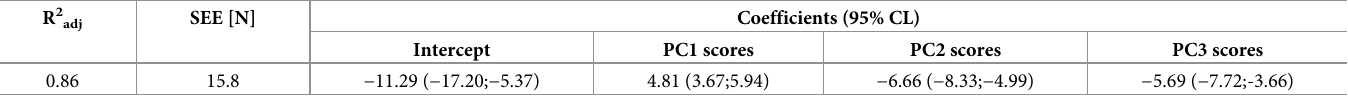
Table 2. A multiple linear regression model to predict differences in vertical barbell force during the snatch computed from the inverse dynamic approach and the work-energy approach using PC scores of principal component analysis from vertical barbell acceleration waveforms. R 2 adj SEE